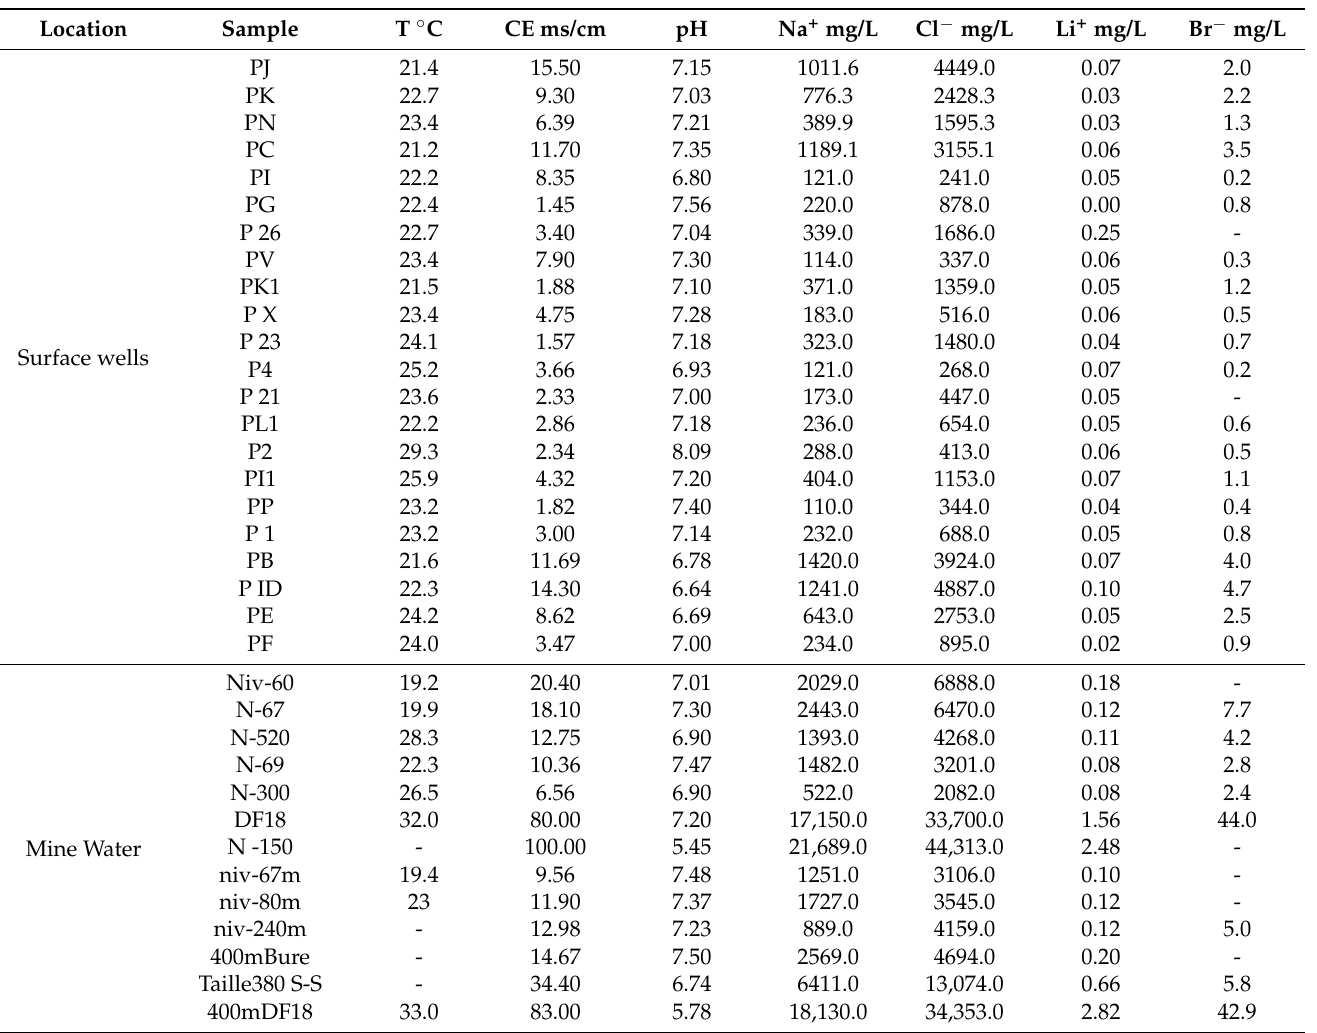
Table 1. Conservative elements concentrations in shallow aquifer and mine